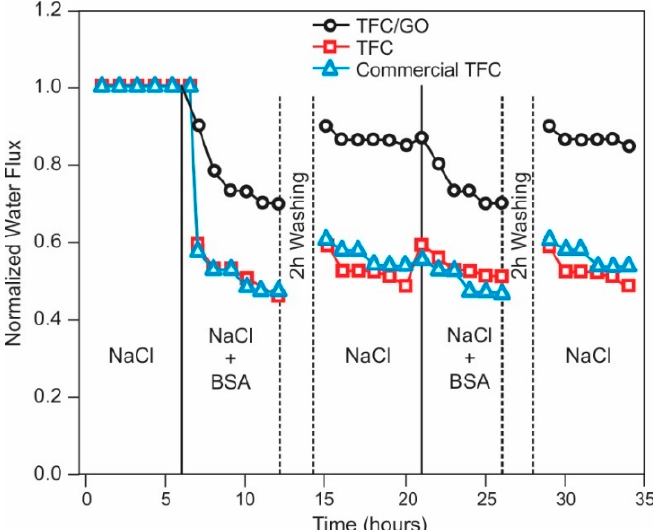
Figure 19. Water flux (normalized to initial water flux) as a function of operating time for GO-embedded polyamide membrane (TFC/GO), house-prepared polyamide membrane (TFC) and a commercially available polyamide membrane (Commercial TFC). Feed solution contained either pure NaCl at 2000 ppm, or 100 ppm BSA + 2000 ppm NaCl. Membrane washing was conducted using water only. Feed temperature, pressure, and pH were not reported. [287] Reprinted with permission of Elsevier B.V.